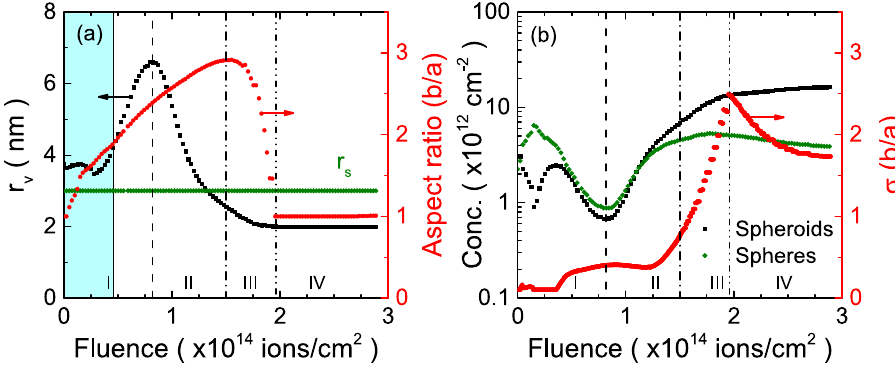
Figure 2. Geometrical and compositional parameters of the ensemble of nanoparticles as a function of the fluence, obtained from the fit of the optical spectra. The parameters are ( a ) the radius of the small spheres ( r s , fixed), the volume-equivalent radius ( r v ) and average aspect ratio ( ε ) of the large rods, ( b ) the concentration of spheres and rods and the standard deviation of the distribution of aspect ratios. The cyan area represents approximately the “pure elongation” region that was used to compare with MD